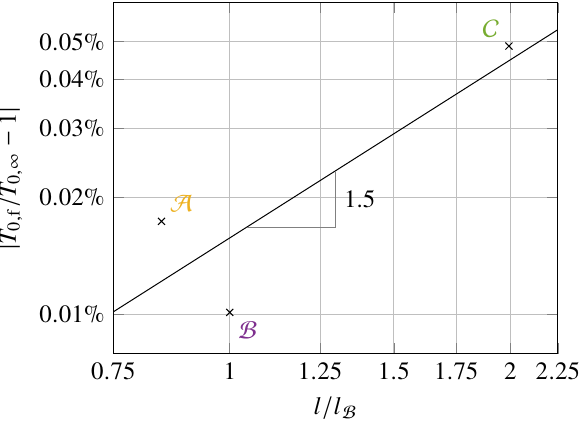
Figure A2. Deviations of the mass-averaged total temperature at propulsor inlet T 0,f from the freestream value against relative cell size h / h B